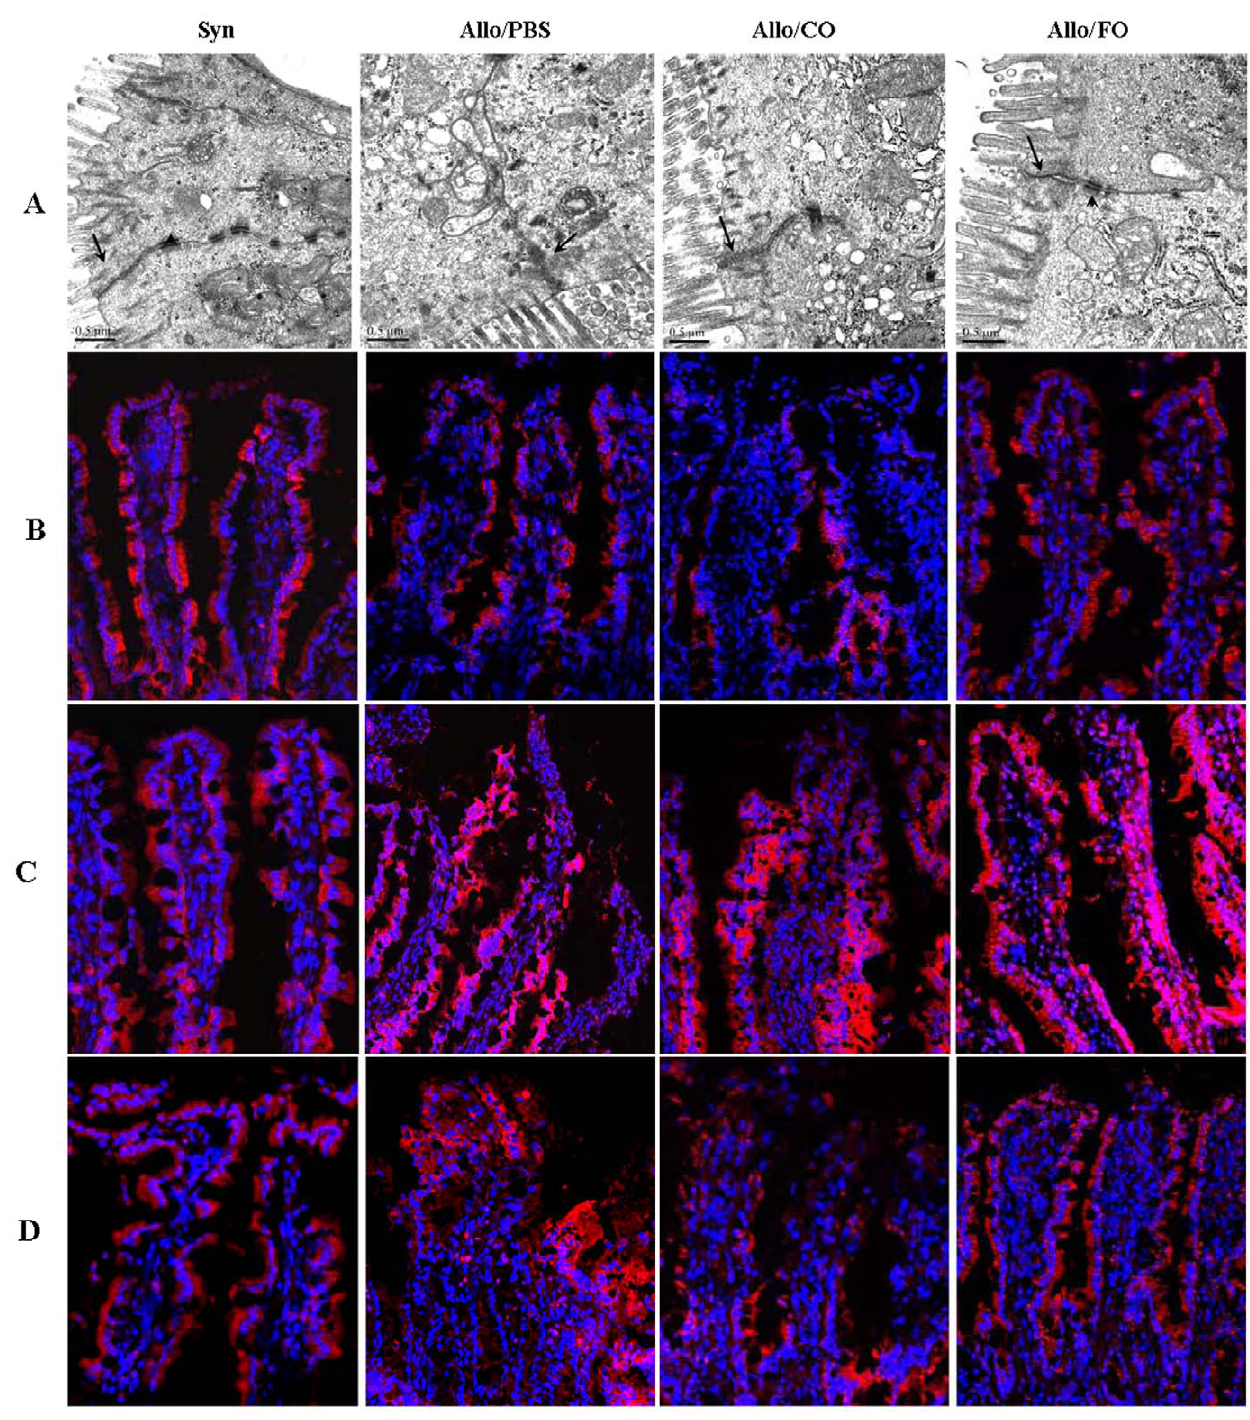
Figure 7. Fish oil prevented the alteration of TJ ultrastructure and redistribution of TJ proteins in intestinal transplant rats. (A): Transmission electron microscopic analysis was performed to investigate changes in the ultrastructure of TJ during chronic rejection. Arrows indicated apical TJ and arrows heads depicted desmosomes. In PBS and CO groups, the electron dense materials decreased significantly, indicating disruption of TJ ultrastructure both in the allograft. In addition, desmosomes disappeared in the two groups. In contrast, fish oil preserved the ultrastructure of TJs. In FO group, TJs and desmosomes displayed intact structure as those in syngeneic group. Bars in the images were 0.5 m m. (B): Examination of the tight junction protein occludin by immunofluorescency. The allograft intestine was subjected to immunostaining with the corresponding antibody. And the distribution of TJ proteins in the epithelium was examined by immunofluorecency. (C): Immunolocalization of claudin-1 in the allograft intestine in intestinal transplant rats. The allograft intestine was subjected to immunostaining with the claudin-1 antibody, and images were captured with a confocal scanning microscope. (D): Immunofluorescence staining for claudin-3. Fish oil prevented redistribution of claudin-3 in the allograft intestine.